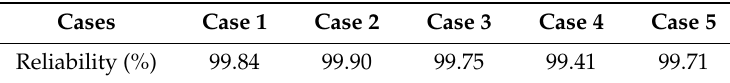
Table 6. Reliability for five di ff erent wind